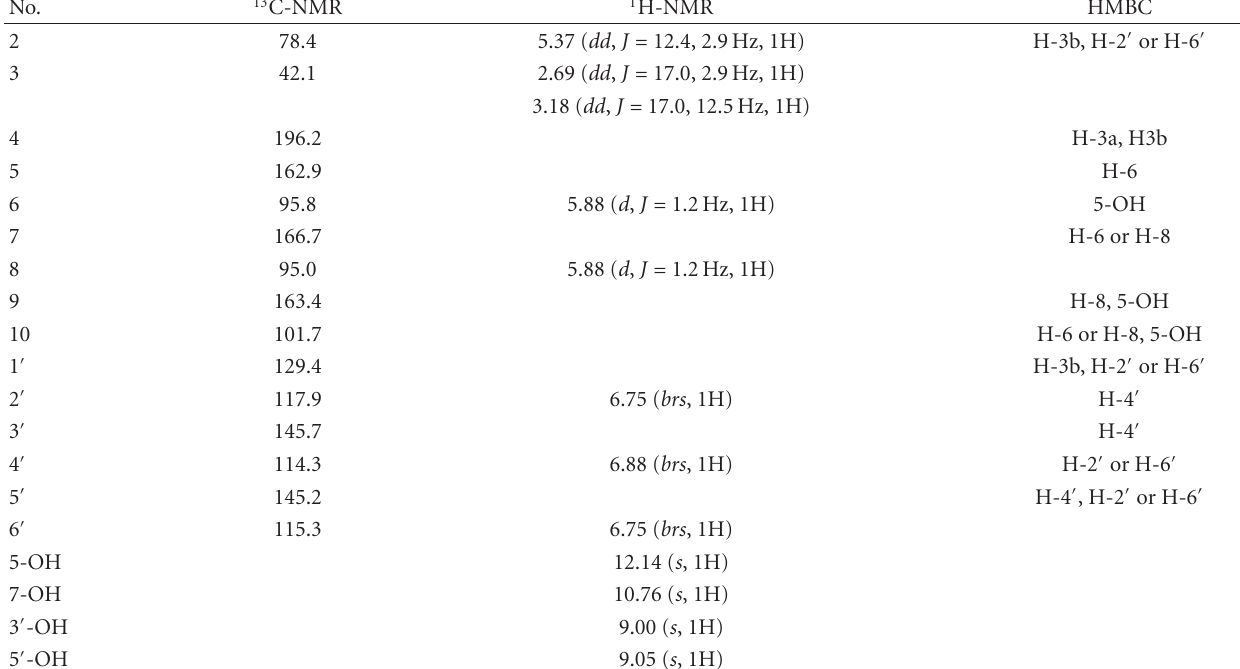
Table 1: NMR spectra of the compound 8 in DMSO- d 6